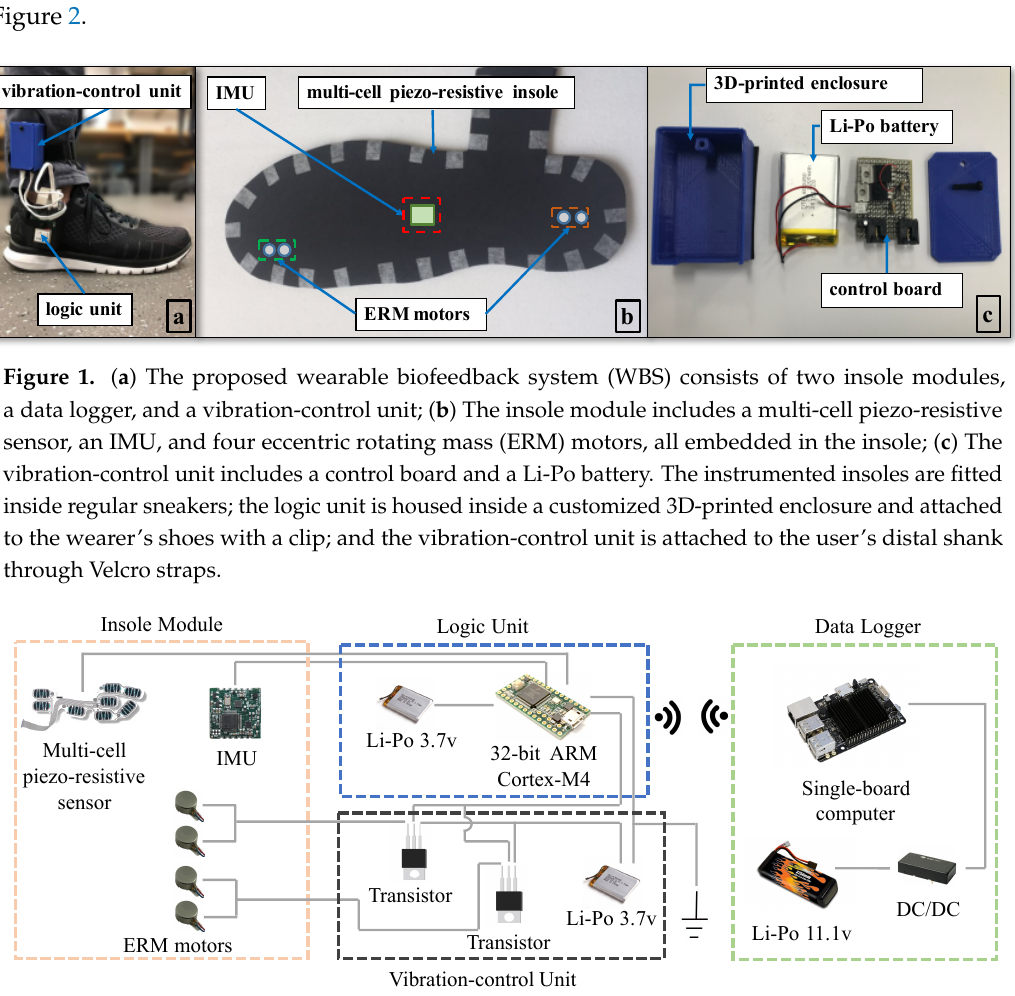
Figure 2. System